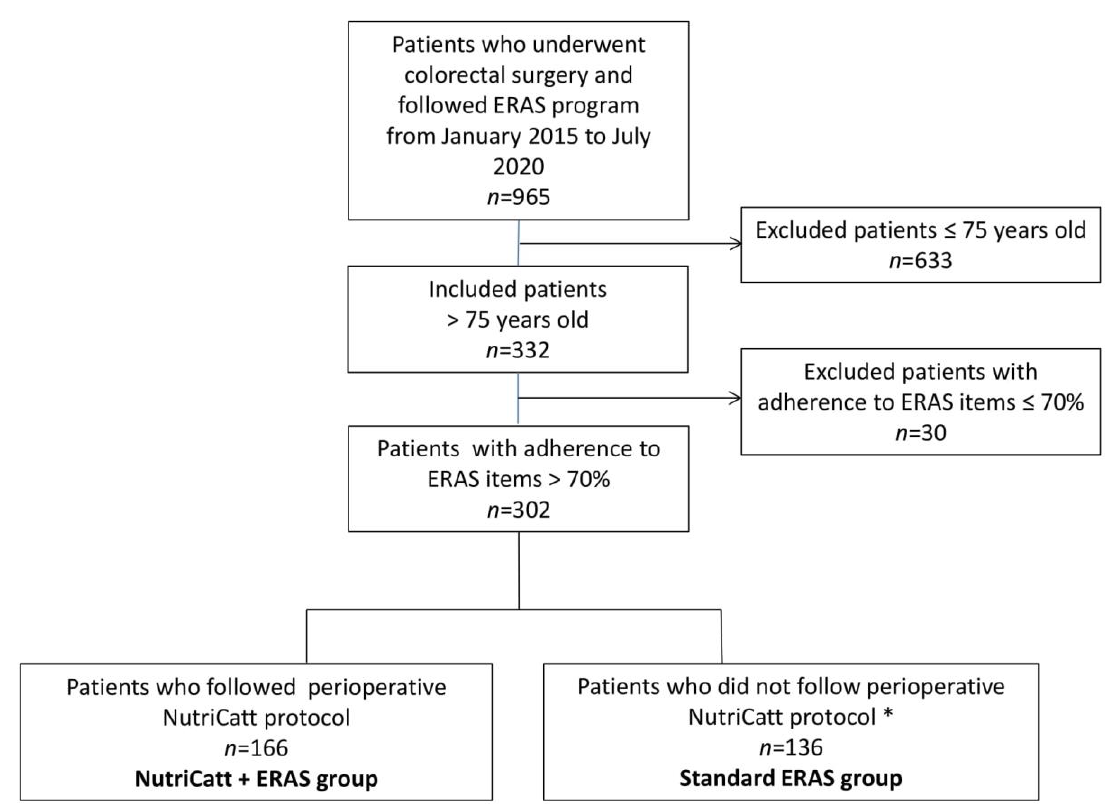
Figure 1. Flowchart of the retrospective cohort study. Abbreviations: ERAS, Enhanced Recovery after Surgery. * for the following reasons: failure to undergo a pre-hospitalization nutritional check, fast-track regimen, emergency intervention. Table 1. Patient